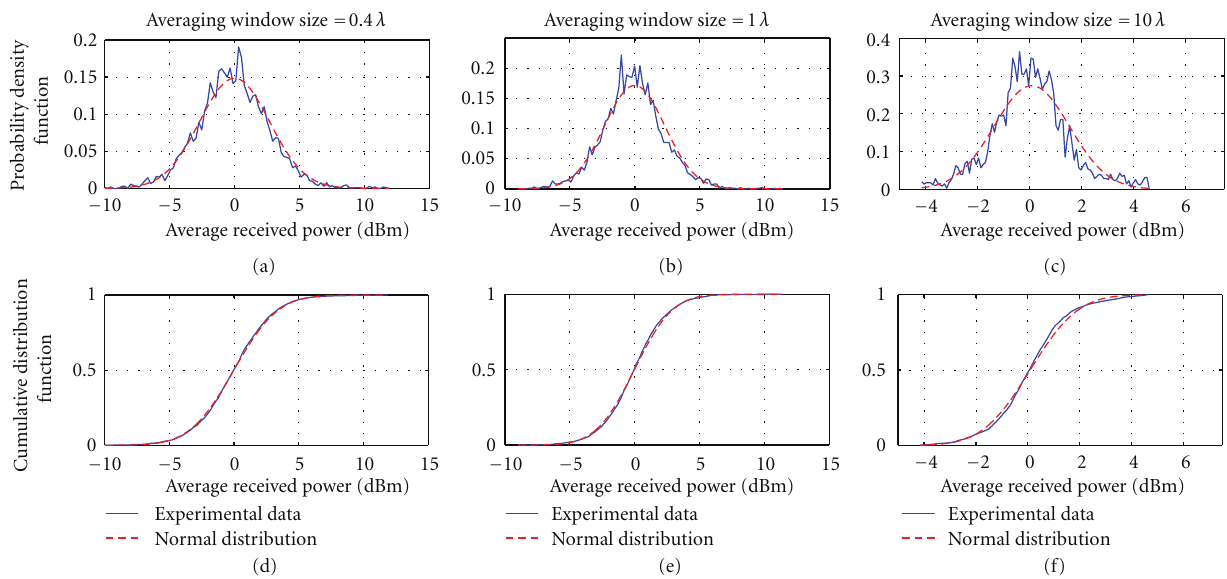
Figure 10: (a–c) pdf and (d–f) cdf of the log of shadow fading (after removing the distance-dependent path loss) and the normal distribution match for all the data gathered in the basement of ECE bulding. The three columns show the impact of the averaging window size on the match: (a, d) window size of 0 . 4 λ , (b, e) window size of 1 . 0 λ , and (c, f) window size of 10 . 0 λ , with λ = 0 . 125 m denoting the wavelength of the transmitted